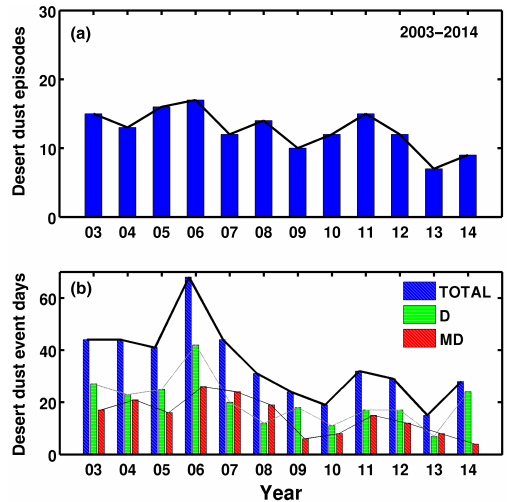
Figure 3. Interannual variability of (a) total number of episodes; (b) total (blue bars) number of days for the desert dust (DD) intru- sions and for desert (D, green bars) and mixed desert (MD, red bars)